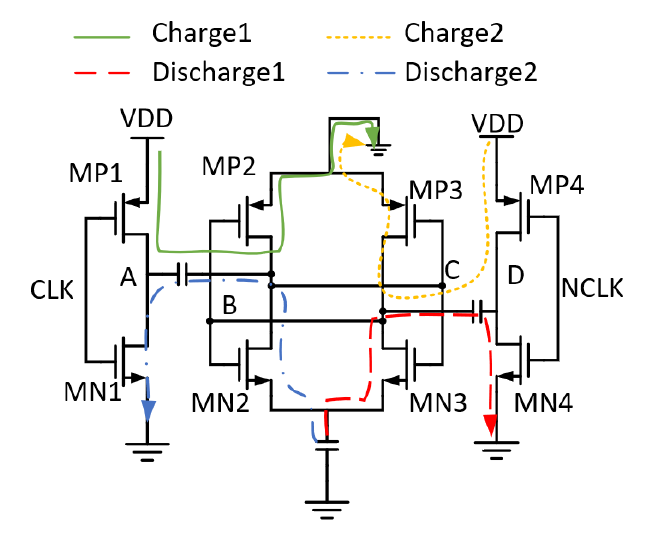
Figure 2. The circuit of traditional